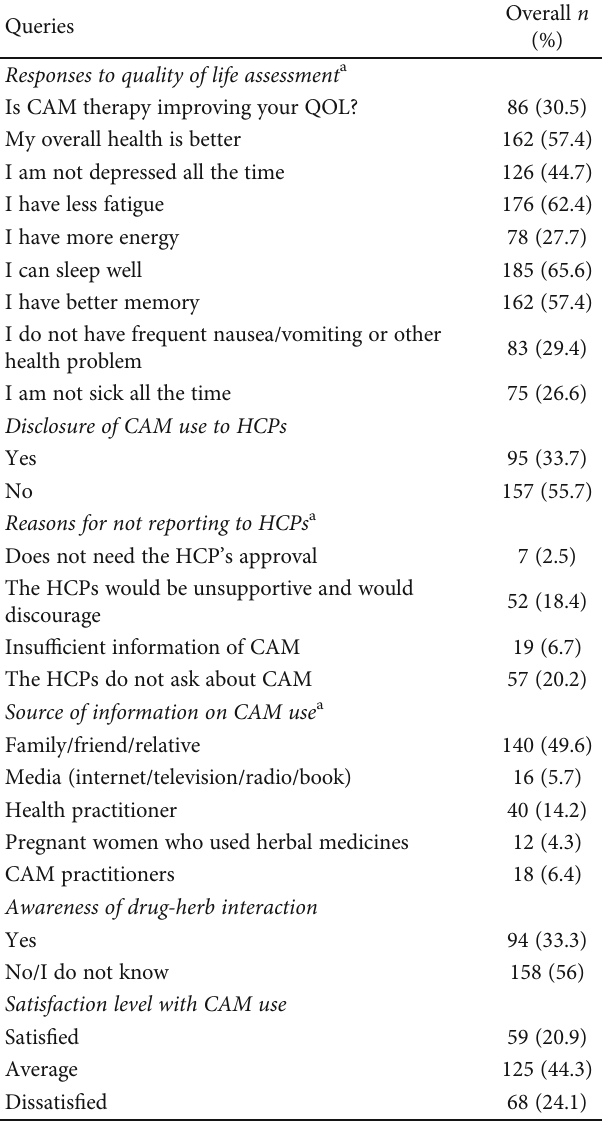
Table 2: The observed responses for the use of CAM in the study participants ( N = 252